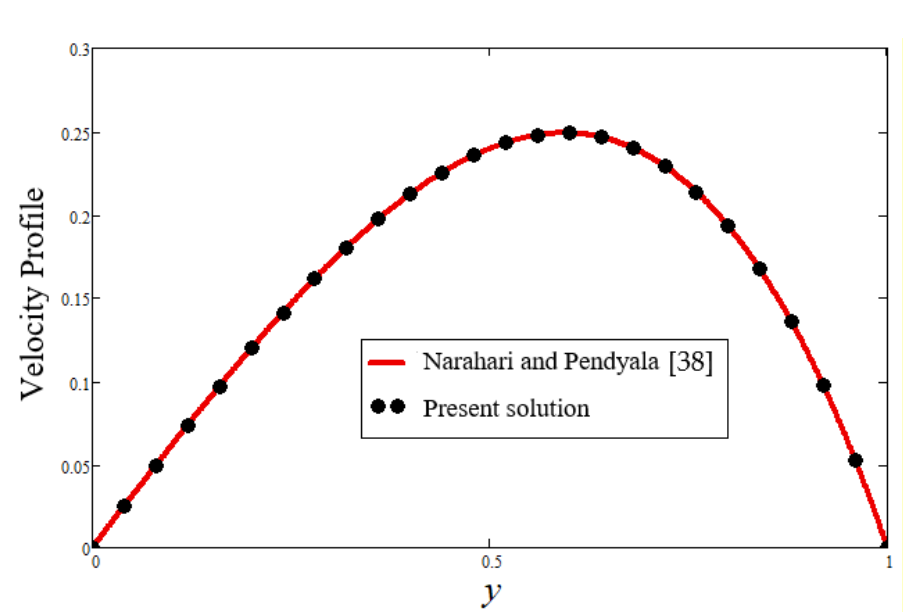
Figure 13. Comparison of the present solutions obtained in Equation (26) when u ( 1, t ) = 0 and K 2 = 0 with Narahari and Pendyala Equation (11).